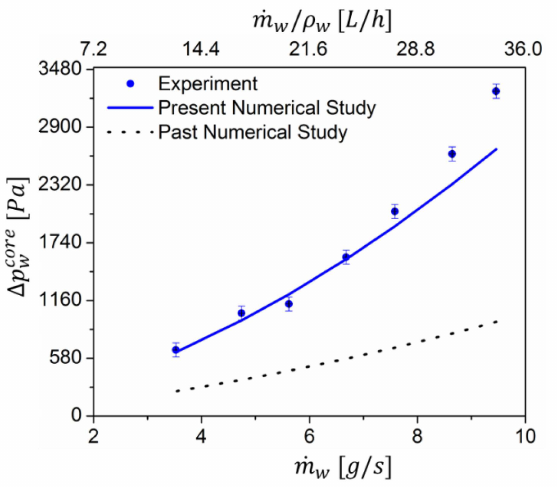
Figure 9. Comparison of experimental and numerical results of ∆ p core